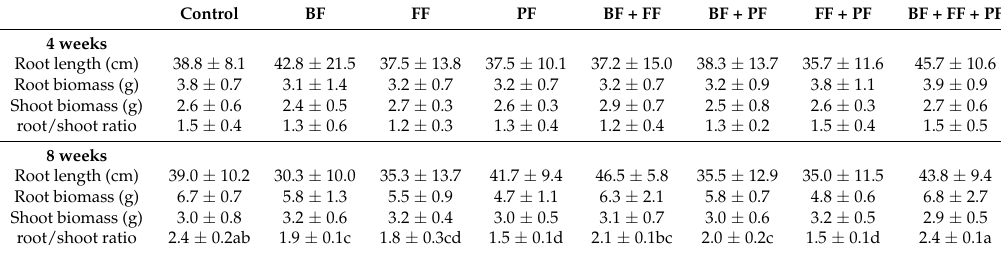
Table 3. Effects of inoculation of nematode trophic groups on root length (cm ± s.d.) root and shoot weight (g DW ± s.d.), and root/shoot ratio ( ± s.d.) of Quercus robur at 4 and 8 weeks after